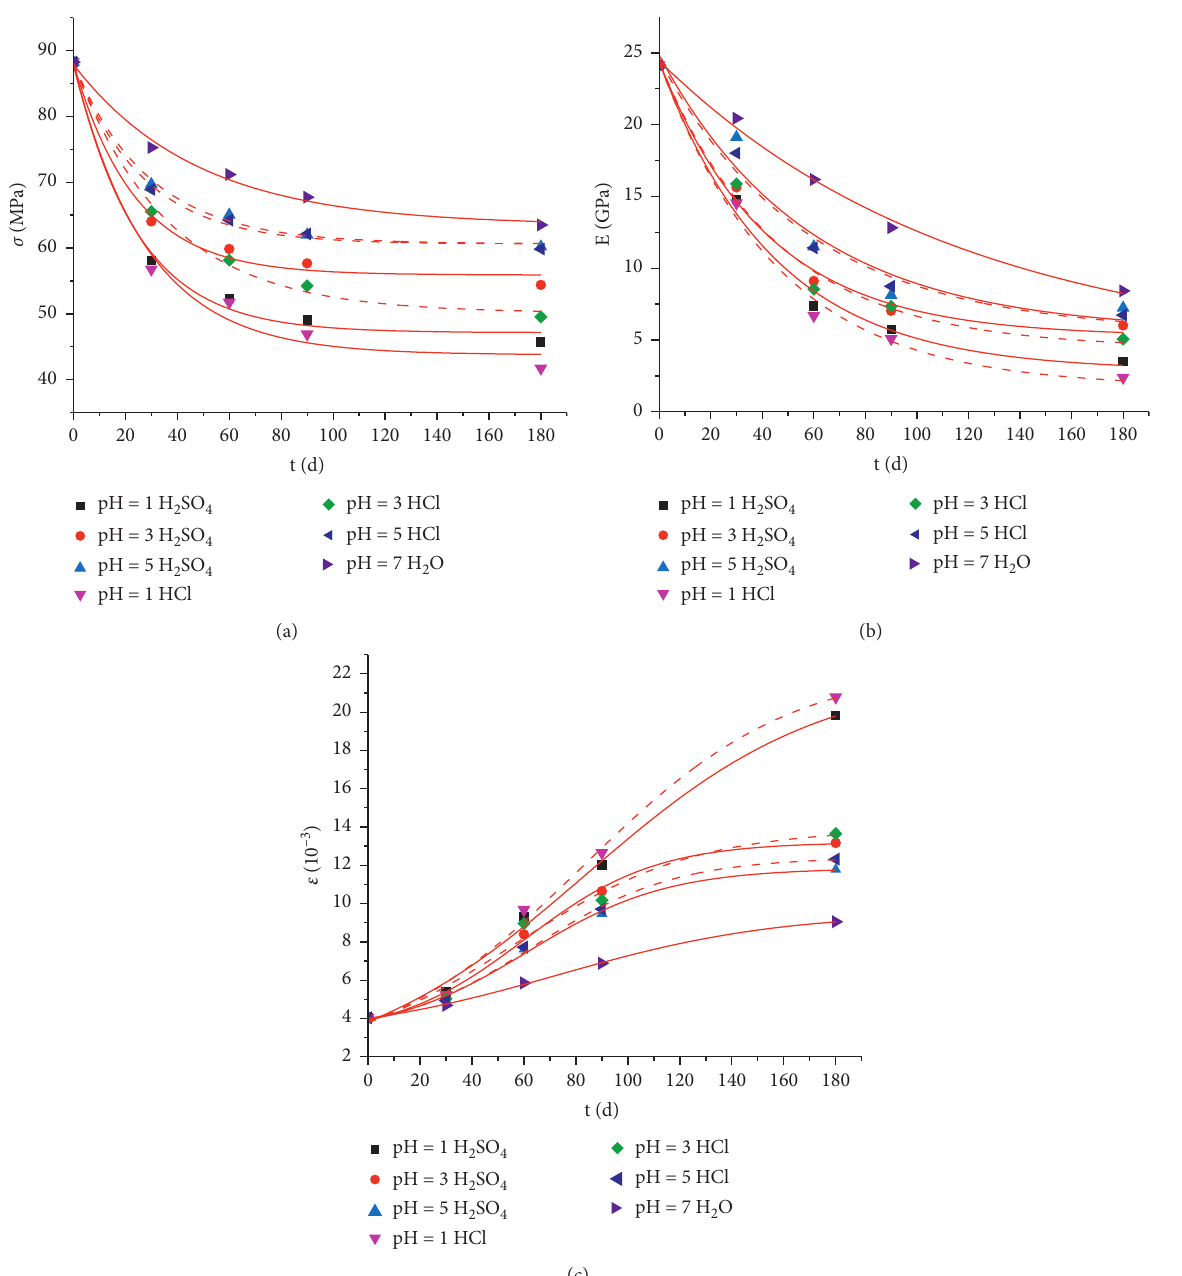
Figure 9: Relationship between (a) the peak stress, (b) the elastic modulus, and (c) the peak stain of sandstone samples and soaking